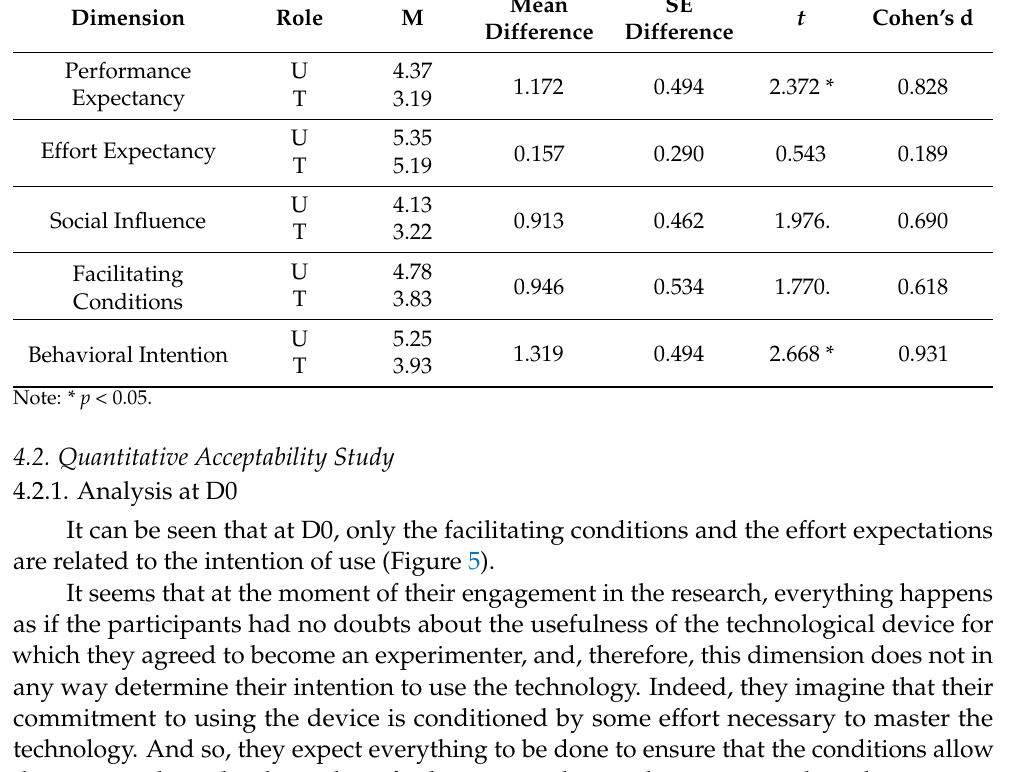
Table 3. Categorization Global evolution of the average dimensions of the UTAUT according to the role mobilized—SHERPAM project (Independent Samples t -Test).